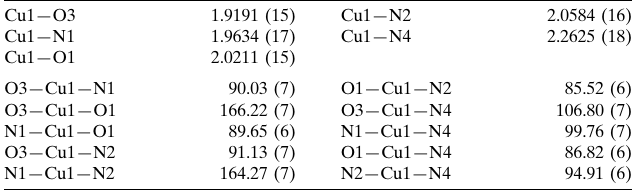
Selected geometric parameters (A˚ , (cid:2) ).